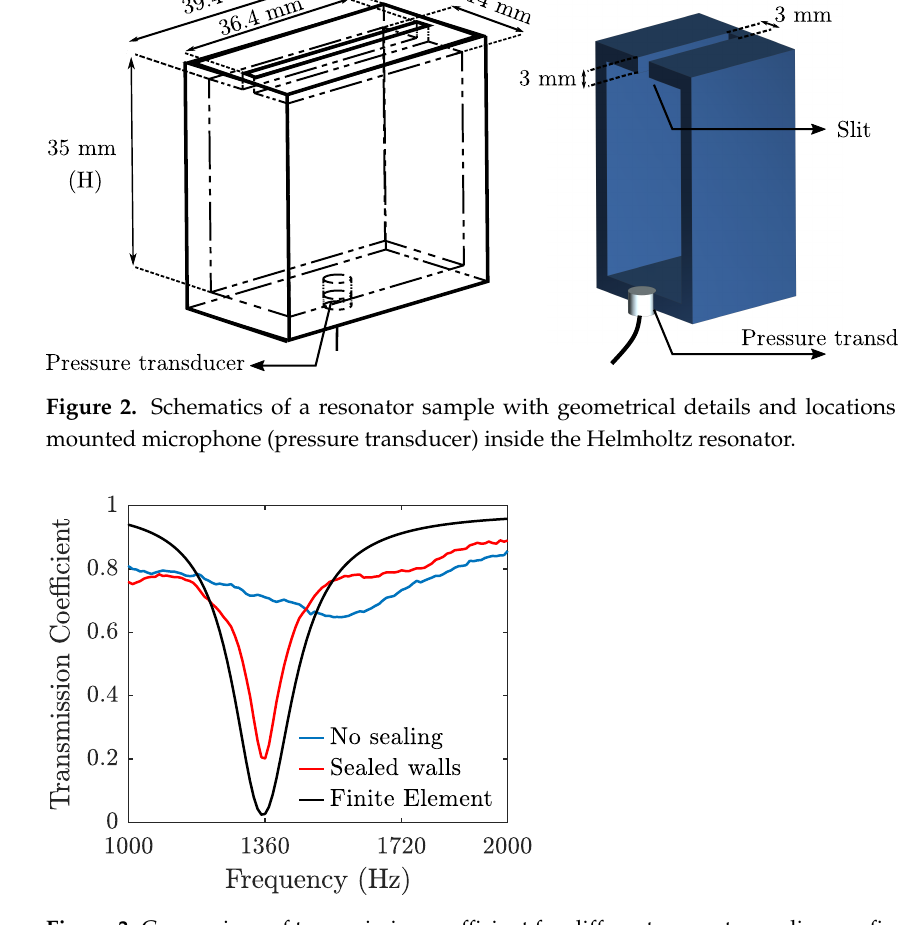
Figure 3. Comparison of transmission coefficient for different resonator sealing